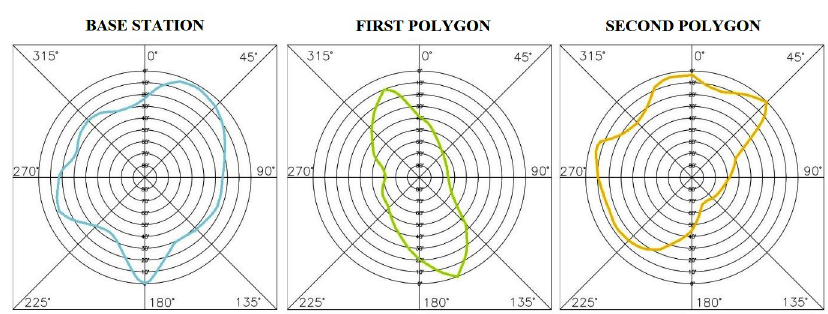
Figure 3. Base station, I and II polygon points horizon openness, where the zero conforms with geographical north direction (Annok, 2019)